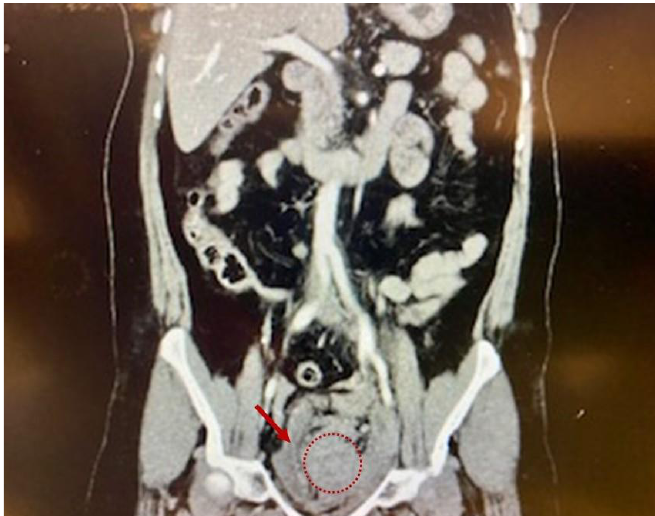
Image 1. Initial computed tomography of the abdomen and pelvis, with pelvic hematoma compressing the bladder and ovaries. Red arrow : compressed and displaced bladder. Dotted circle : forming pelvic